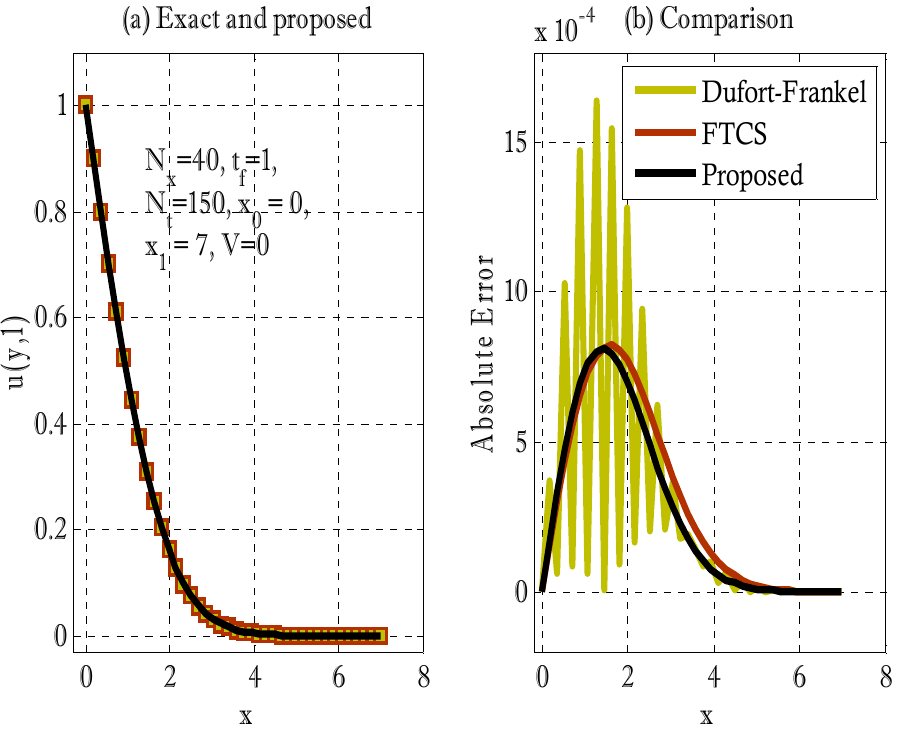
Figure 2. Comparison of the proposed scheme with the FTCS and Dufort–Frankel methods.